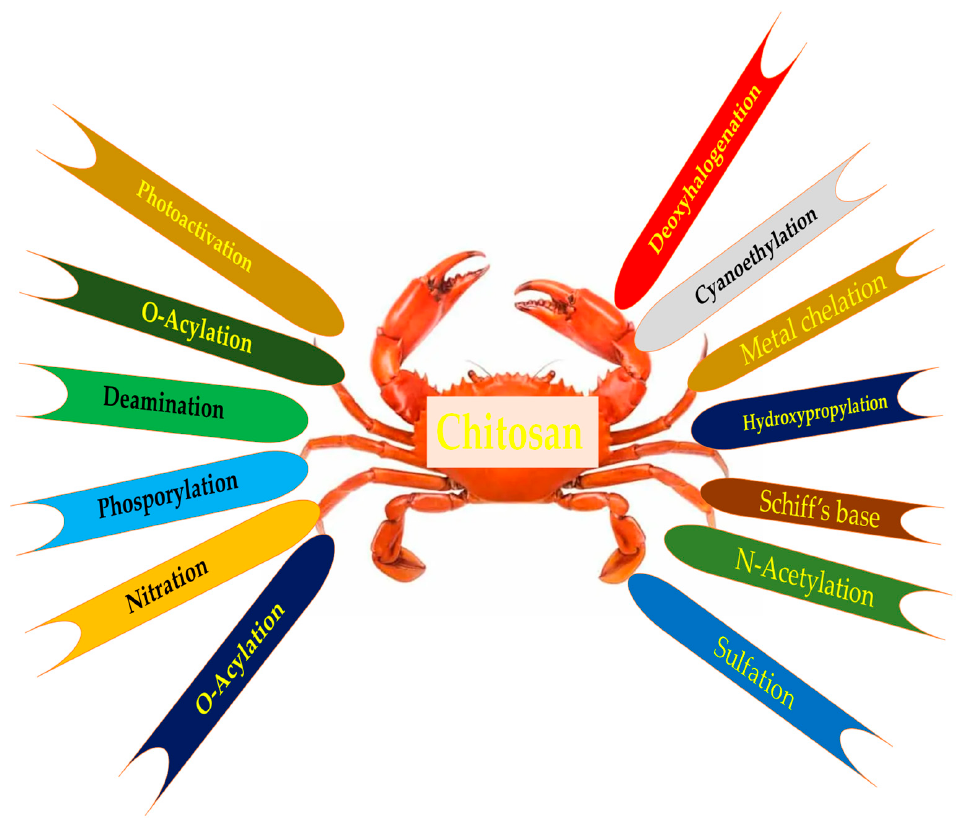
Figure 1. Overview of various chemical modification processes that go into the making of chitosan derivatives.